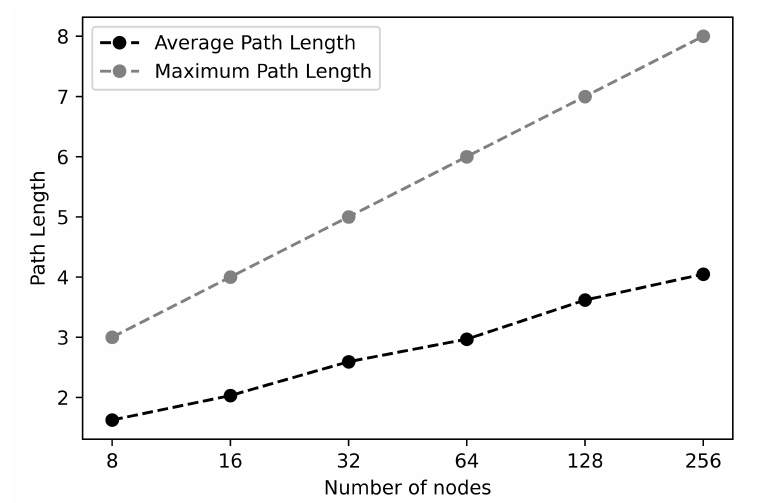
Figure 9. Average and maximum path length as a function of the network